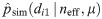
Distributions of pairwise distances for populations simulated with different parameters.The histograms show the estimated probability mass functions p^sim(di1|neff,μ) with selected parameter vectors (neff, μ). Increasing μ and/or neff tends to increase the distances. Each histogram represent variability in a simulated population at a single time point 6,000 generations after the beginning of the simulation.